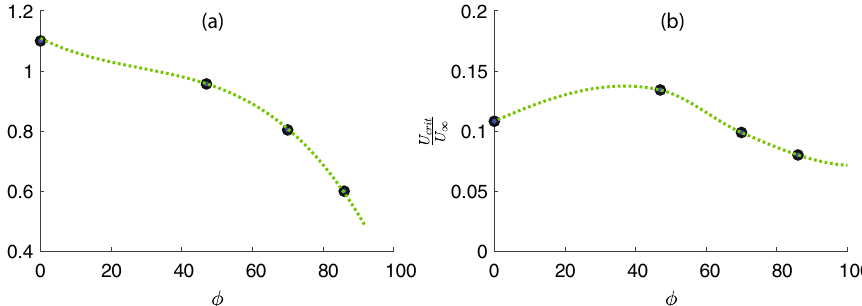
Figure 3. ( a ) The drag coefficient versus patch porosity 25 . ( b ) Critical velocity obtained based on Eq. (1) which indicates initiation of the sediment transport. Erosion occurs if the flow velocity over the sediments is exceeded by the critical velocity that reached the peak at φ = 47% .